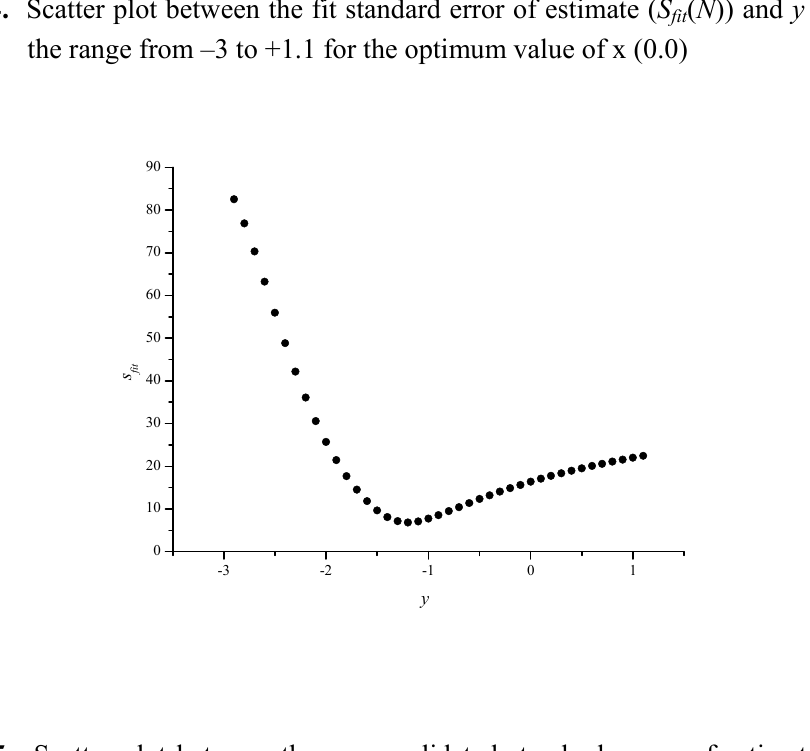
( N )) and y values in fit